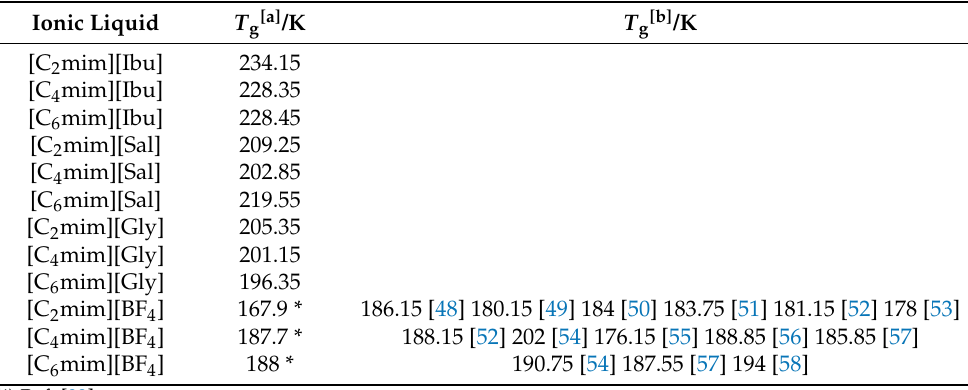
Table 1. The glass-transition temperature of the selected ILs in [a]—this study (obtained from DSC data); [b]—literature data.